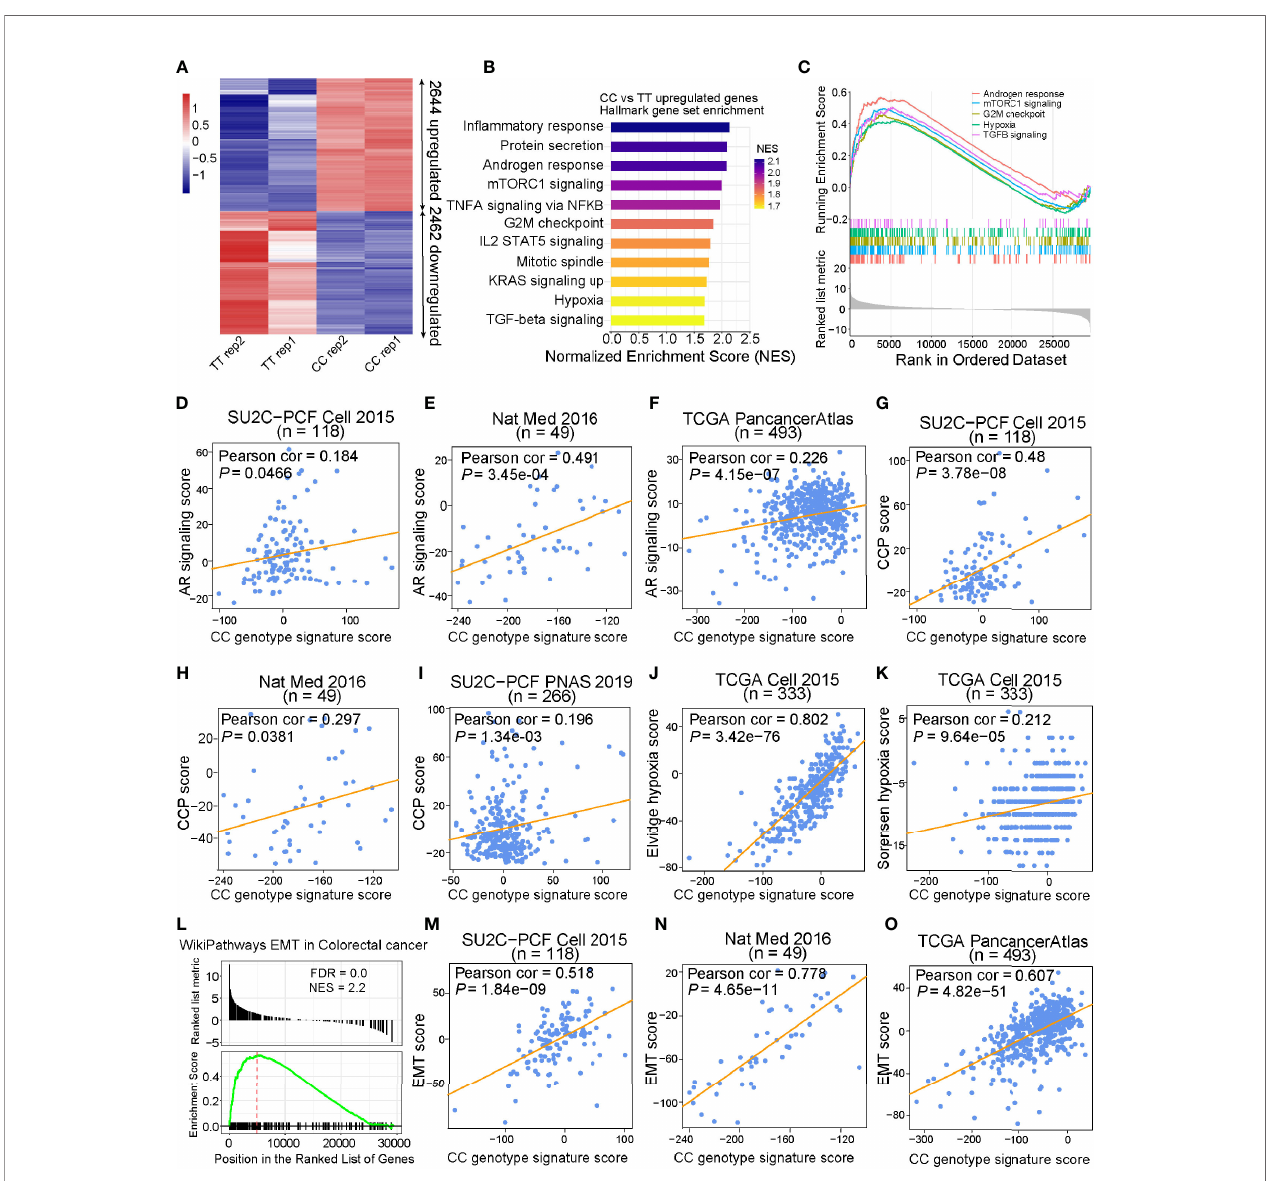
FIGURE 5 | CC alleles upregulated cell cycle and EMT genes that are associated with cancer. (A) Heatmap of CC allele target genes measured by RNA-Seq (FDR < 0.05). (B) Hallmark gene sets enriched in genes upregulated by CC allele. Gene sets were ranked by normalized enrichment score with FDR < 0.01. (C) Gene Set Enrichment analysis (GSEA) of CC upregulated genes in Androgen response, mTORC1 signaling, G2M checkpoint, hypoxia, and TGFB signaling from Hallmark gene sets. (D – F) CC genotype gene signature score based on z -score sum of the 205 differentially expressed genes targeted by CC alleles revealed strong linear positive correlation with AR signaling score in SU2C-PCF, Nat Med, and TCGA cohorts. (G – I) Scatter plots displaying signi fi cant positive correlation between CC genotype signature score and cell cycle progression (CCP) score in SU2C-PCF, Nat Med, and SU2C-PCF PNAS cohorts. (J, K) Pearson correlation examination demonstrated that there was positive linear correlation between CC genotype signature score and hypoxia score in the TCGA cohort. (L) CC upregulated genes enriched in epithelial – mesenchymal transition (EMT) in colorectal cancer from WikiPathways. (M – O) CC genotype signature score showed strong linear positive correlation with EMT score in SU2C-PCF, Nat Med, and TCGA cohorts, respectively. Genes were ranked based on the statistics “ stat ” of DESeq2 result between CC and TT